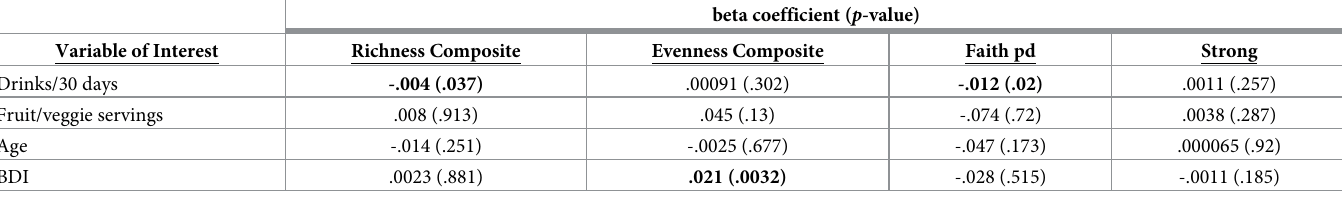
Table 5. Associations between microbiome composites and variables of interest.